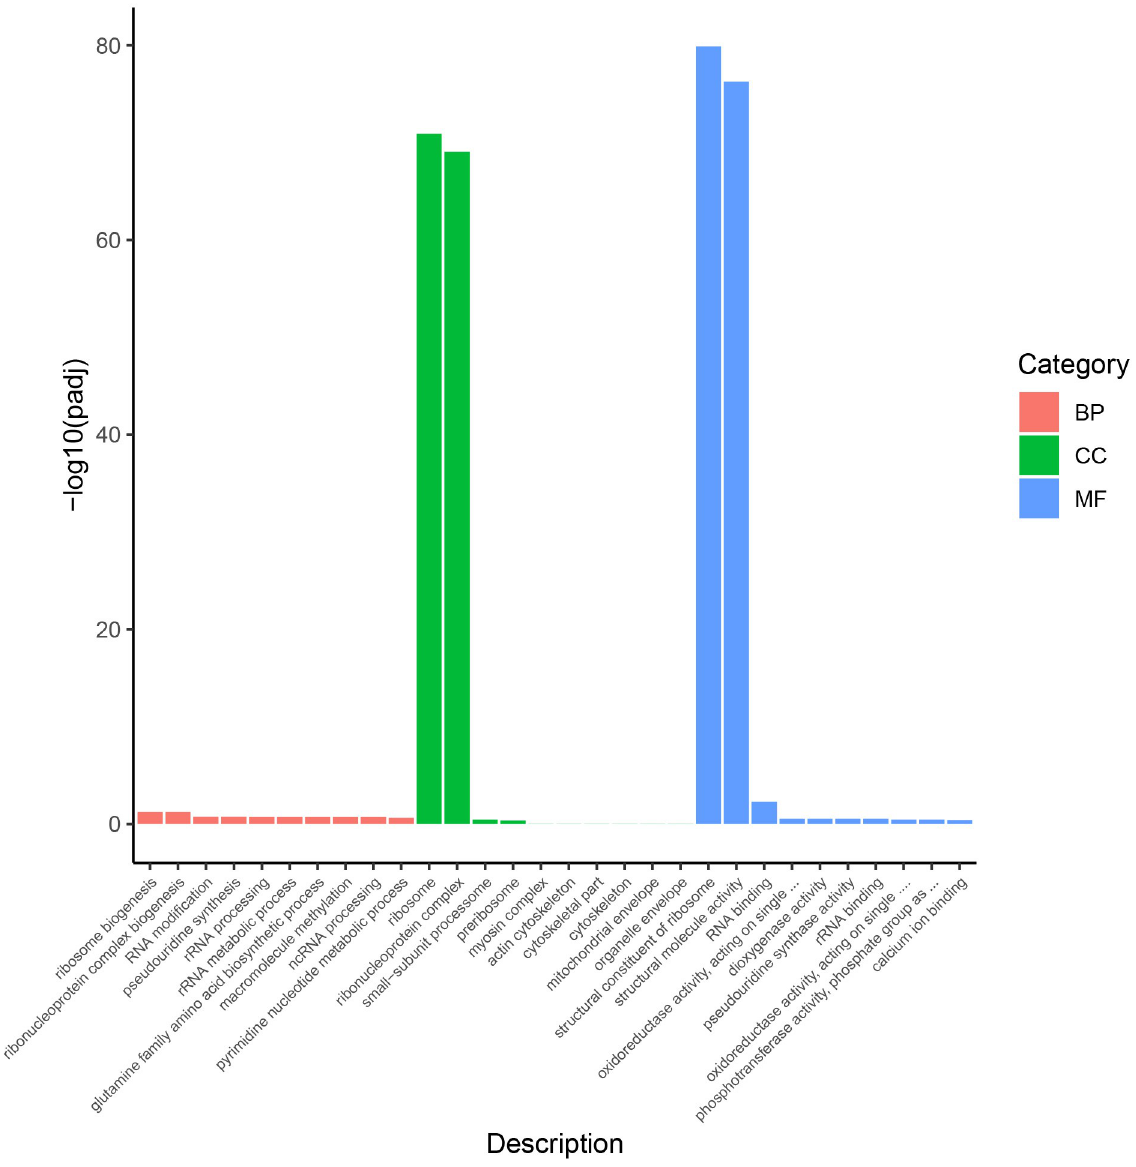
Fig 6. Histogram of differential gene GO